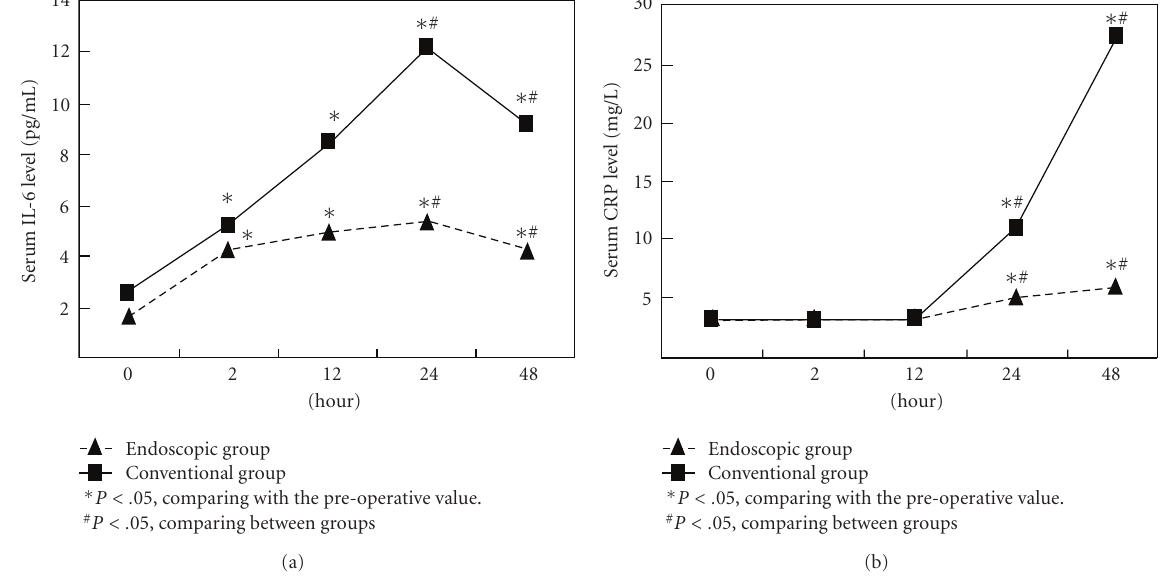
Figure 1: Time course of serum IL-6 and CRP levels among conventional and endoscopic groups before and after operation.